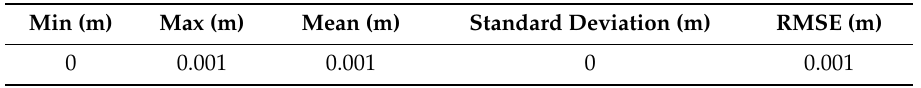
Table 17. Statistical values of the residuals for the East coordinates after reprojection from UTM / WGS84 to OSPM / WGS84.